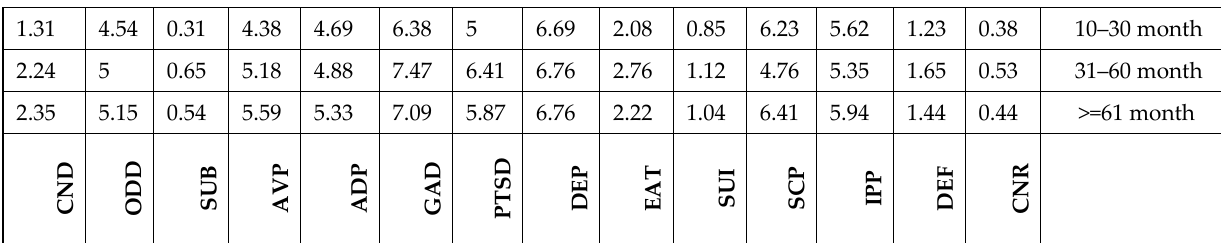
Figure 3. Comparison between A, B, C subgroups concerning the duration of disease. Legend: Conduct Disorder (CND), Oppositional Defiant Disorder (ODD), Substance Abuse Disorder (SUB), Anger/Violence Proneness (AVP), Academic Problems (ADP), Generalized Anxiety Disorder (GAD), Post-Traumatic Stress Disorder (PTSD), Major Depression (DEP), Eating Disturbance (EAT), Suicide (SUI), Self-Concept (SCP), and Interpersonal Problems (IPP), Defensiveness (DEF) and Consistency Response (CNR). Table 4. Significant results for female vs. male (adolescents with diabetes).